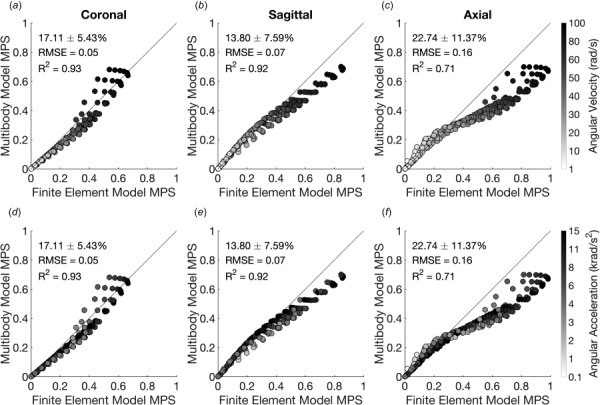
Comparison of MBM and FEM performance from sinusoidal impact traces. Cases are colored according to the peak angular velocity (a)–(c) and peak angular acceleration (d)–(f) of the impact trace. MBM closely predicted FEM MPS at low angular velocities but showed distinct differences in impact pulses with high angular velocities and low accelerations.